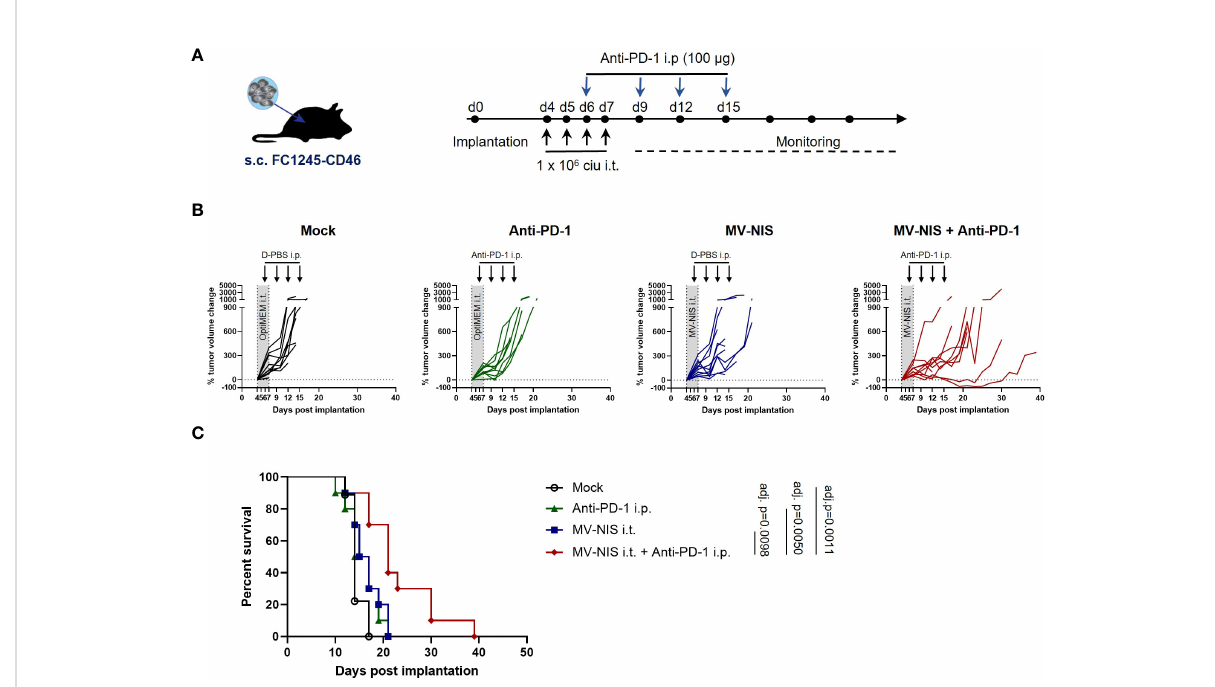
FIGURE 2 Ef fi cacy of MV-NIS and anti-PD-1 in an immunocompetent PDAC model. (A) Treatment schedule. FC1245-CD46 cells were implanted subcutaneously into the fl anks of C57BL/6 mice. When tumors reached an average volume of 75 mm³ (day 4 post implantation), treatment was initiated according to the depicted schedule. Animals received intratumoral injections of 1x10 6 cell infectious units (ciu) of MV-NIS or PBS (control groups) on four consecutive days. From day 3 of virus treatment onwards, animals received intraperitoneal injections of 100 μg of anti- PD-1 antibody or PBS (control groups) every third day for a total of four doses. (B) Individual tumor growth curves for mice treated with PBS only (mock), MV-NIS only, anti-PD-1 only or the combination of MV-NIS and anti-PD-1. Relative changes in tumor volume in comparison to pre-treatment tumor volume over time are shown. (C) Kaplan-Meier survival analysis. Data were analyzed using Mantel-Cox (log rank) test with Bonferroni correction for multiple